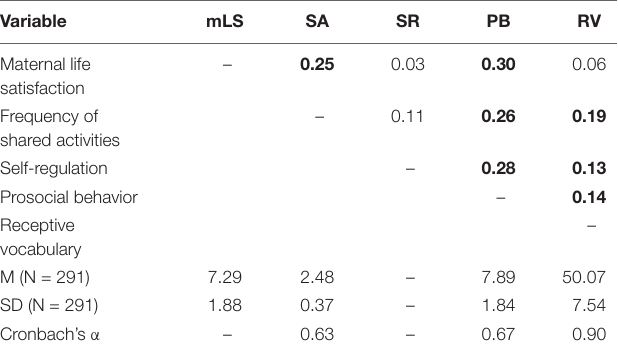
TABLE 1 | Bivariate Correlations, means, standard deviations, and Cronbach’s alphas for the study variables.